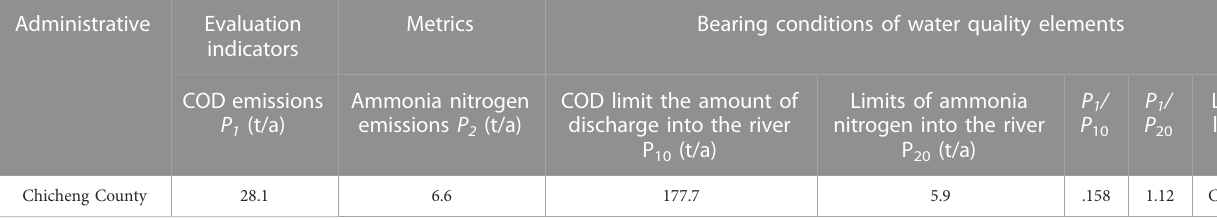
TABLE 6 Results of the evaluation of the elements of the river into the river in the current year (2018). Administrative